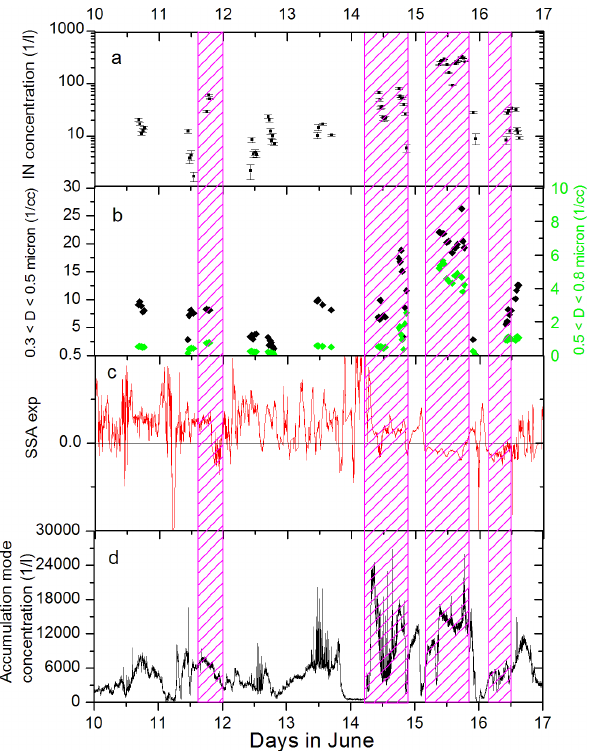
Fig. 7. As Fig. 4 but from 10 to 16 June 2009. The magenta shaded area represents period with high IN number concentration and which could be attributed to Saharan dust